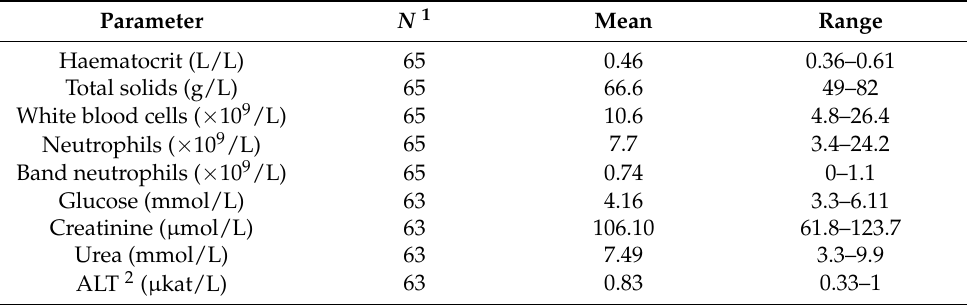
Table 2. Laboratory findings in dogs in the meningoencephalitis of unknown origin (MUO) group ( N =